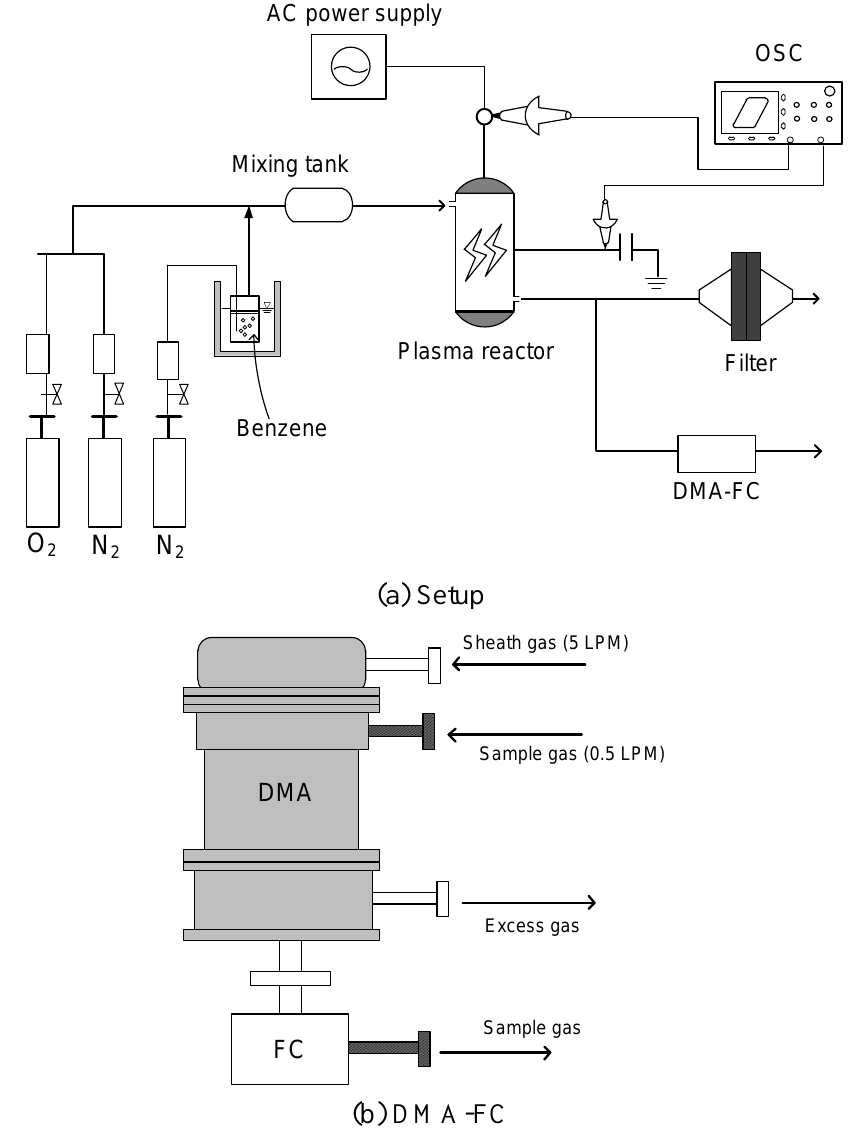
Figure 1. Schematic diagram of the experimental setup (a) and differential mobility analyzer (DMA) and Faraday cup (FC) for aerosol measurement (b)